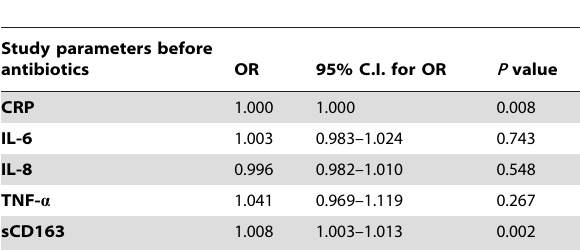
Table 7. Diagnostic predictors of neonatal sepsis before initiation of antibiotic therapy.